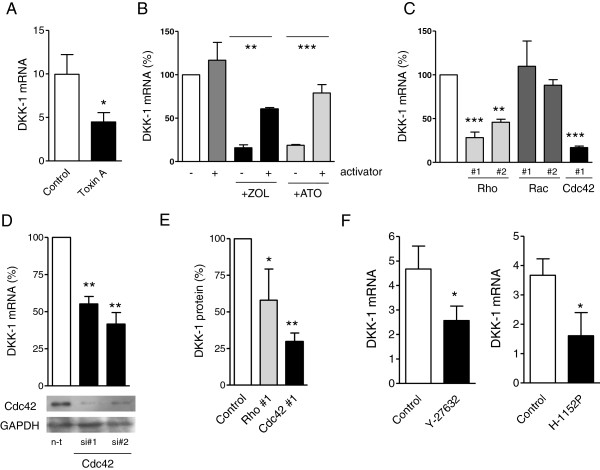
Dickkopf-1 is regulated via Cdc42 and Rho in breast cancer. (A) MDA-231 cells were treated for 48 hours with Clostridium difficile toxin A (250 ng/ml) and assessed for Dickkopf-1 (DKK-1) expression. (B) MDA-231 cells were exposed to zoledronic acid (ZOL) or atorvastatin (ATO) alone or concurrently with a Rho/Rac/Cdc42 activator for 24 hours. Due to the relatively short half-life of the activator, cells were treated every 5 hours with 1 μg/ml of activator until cells were harvested after 15 hours. (C) MDA-231 cells were treated with a number of different GTPase inhibitors for 24 hours and assessed for DKK-1 expression. Concentrations used were 10 μM for Rho#1 and Rho#2, 100 μM for Rac#1, 10 μM for Rac#2 and 50 μM for the Cdc42 inhibitor. (D) MDA-231 cells were transfected with control single interfering RNA (siRNA) or two different siRNAs directed against Cdc42. Sufficient knockdown was verified by western blot. DKK-1 expression was analyzed 48 hours after transfection. (E) Regulation of DKK-1 by Cdc42 and Rho was verified at protein levels, by measuring DKK-1 levels in the supernatant of MDA-231 cells treated with the same inhibitors as in C. (F) The role of Rho signaling was further confirmed by measuring DKK-1 levels following 24 hours of Rho-associated protein kinase inhibition using Y-27632 and H-1152P. Results of enzyme-linked immunosorbent assay and polymerase chain reaction data are presented as the mean ± standard deviation of three independent experiments. *P < 0.05; **P < 0.01; ***P < 0.001. GAPDH, glyceraldehyde 3-phosphate dehydrogenase.